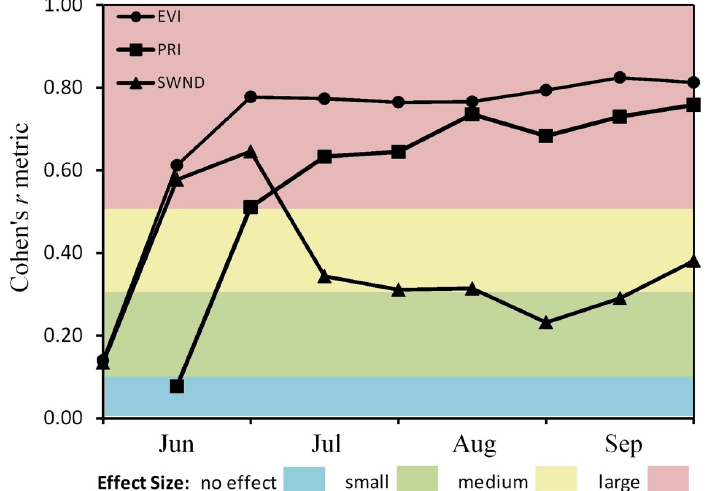
Figure 11. Variations in Cohen’s r metric of e ff ect size (absolute values) at site 2 (Manaus), derived from the non–parametric Mann–Whitney U test. The magnitude of the BRDF e ff ects is indicated for the enhanced vegetation index (EVI), photochemical reflectance index (PRI), and shortwave infrared normalized difference (SWND). The limits of the effect size are based on Cohen [32].